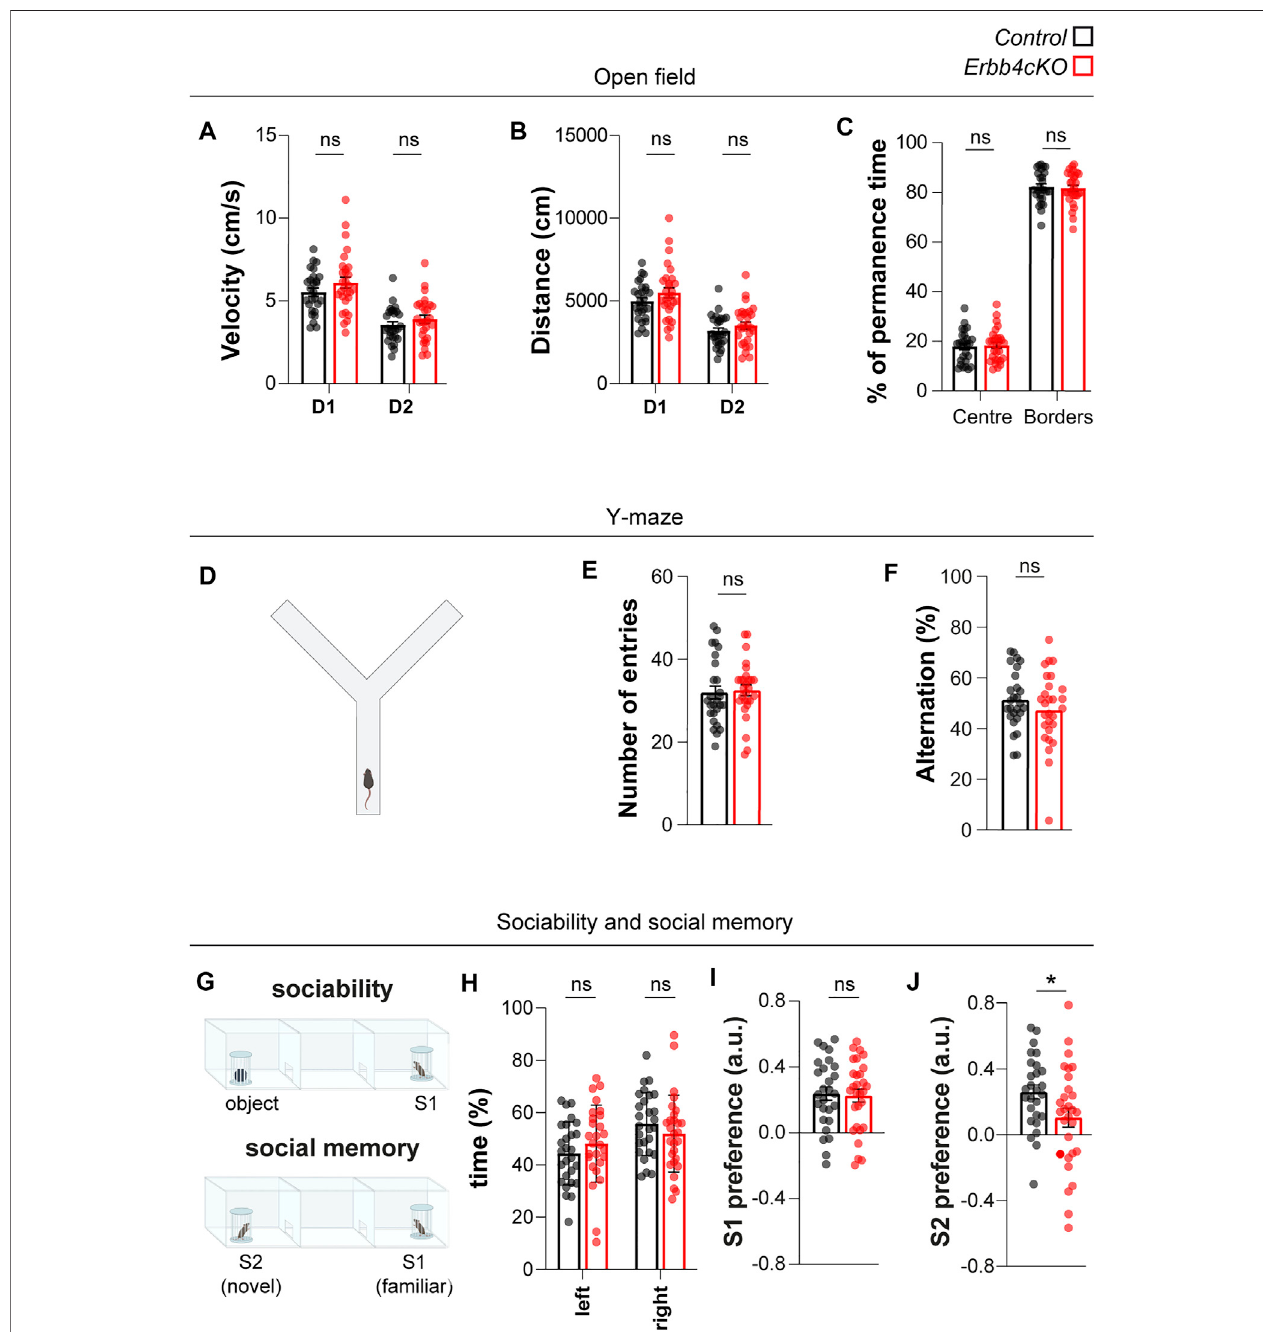
FIGURE 5 | Mice with Erbb4 deletion in Pet1 + neurons display social memory de fi cits but no phenotypes on sociability, locomotor activity or attentional levels. (A – C) Locomotor activity in the open fi eld during day 1 (D1) and day 2 (D2) of control and Erbb4cKO mice is represented as velocity (A) and distance travelled (B) . (C) Percentageofpermanencetimeinthecentreandbordersoftheopen fi eld. (D,E) LocomotoractivitywasmeasuredintheY-mazeastotalnumberofentries. (F) Working memory measured as percentage of spontaneous alternations during Y-maze test. (G) Schematic of the sociability test and social novelty test. (H) Percentage of time spent in the lateral chambers during the habituation phase to the 3-chamber test. (I) Index of preference of S1 versus object during sociability phase. (J) Index of preference of S2 versus S1 during social memory phase. In the statistical analysis of all experiments described in this fi gure, the sex perspective has been included. Animals of both sexes were included in the samples of each experiment. After checking that patterns of data distribution were common in males and females via a strati fi ed analysis by sex, pooled analysis was carried out. For all these behavioral tests, n (cid:2) 27 (11 females, 16 males) control and n (cid:2) 29 (12 females, 17 males) mutant from 7 different litters. Data are represented as mean ± SEM. ns: not signi fi cant differences; *: p < 0. 05. t-test, Mann-Whitney or two-way ANOVA with Bonferroni correction for multiple comparisons.